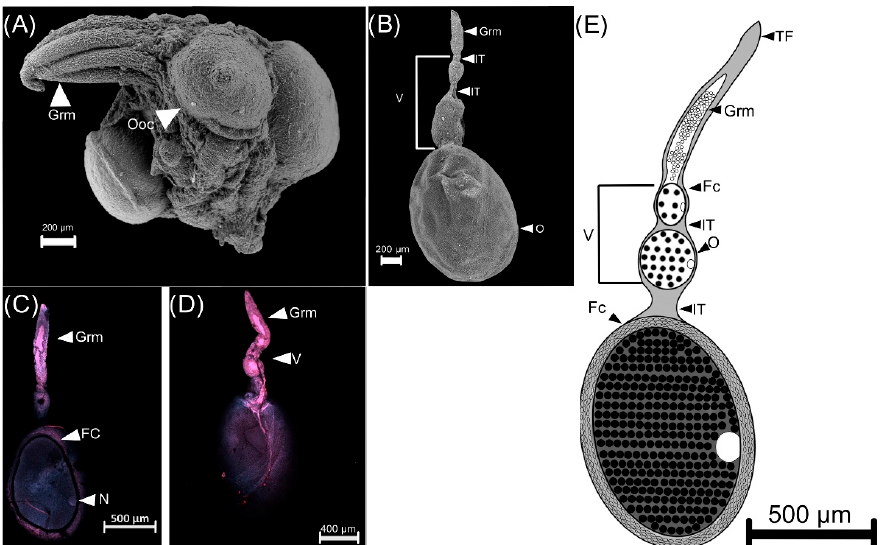
Figure 9. Telotrophic ovary of Cyclocephala barrerai . ( A ) ovary of 6 d old female, ( B ) ovariole of 12 d old female, ( C , D ) ovarioles (confocal scanning laser microscopy view). ( E ) scheme of ovary. Grm = gremarium, Ooc = oocyte, Fc = Follicular cells, V = vitellarium, TF = terminal filament, N = nucleus, IT = interfollicular tissue.